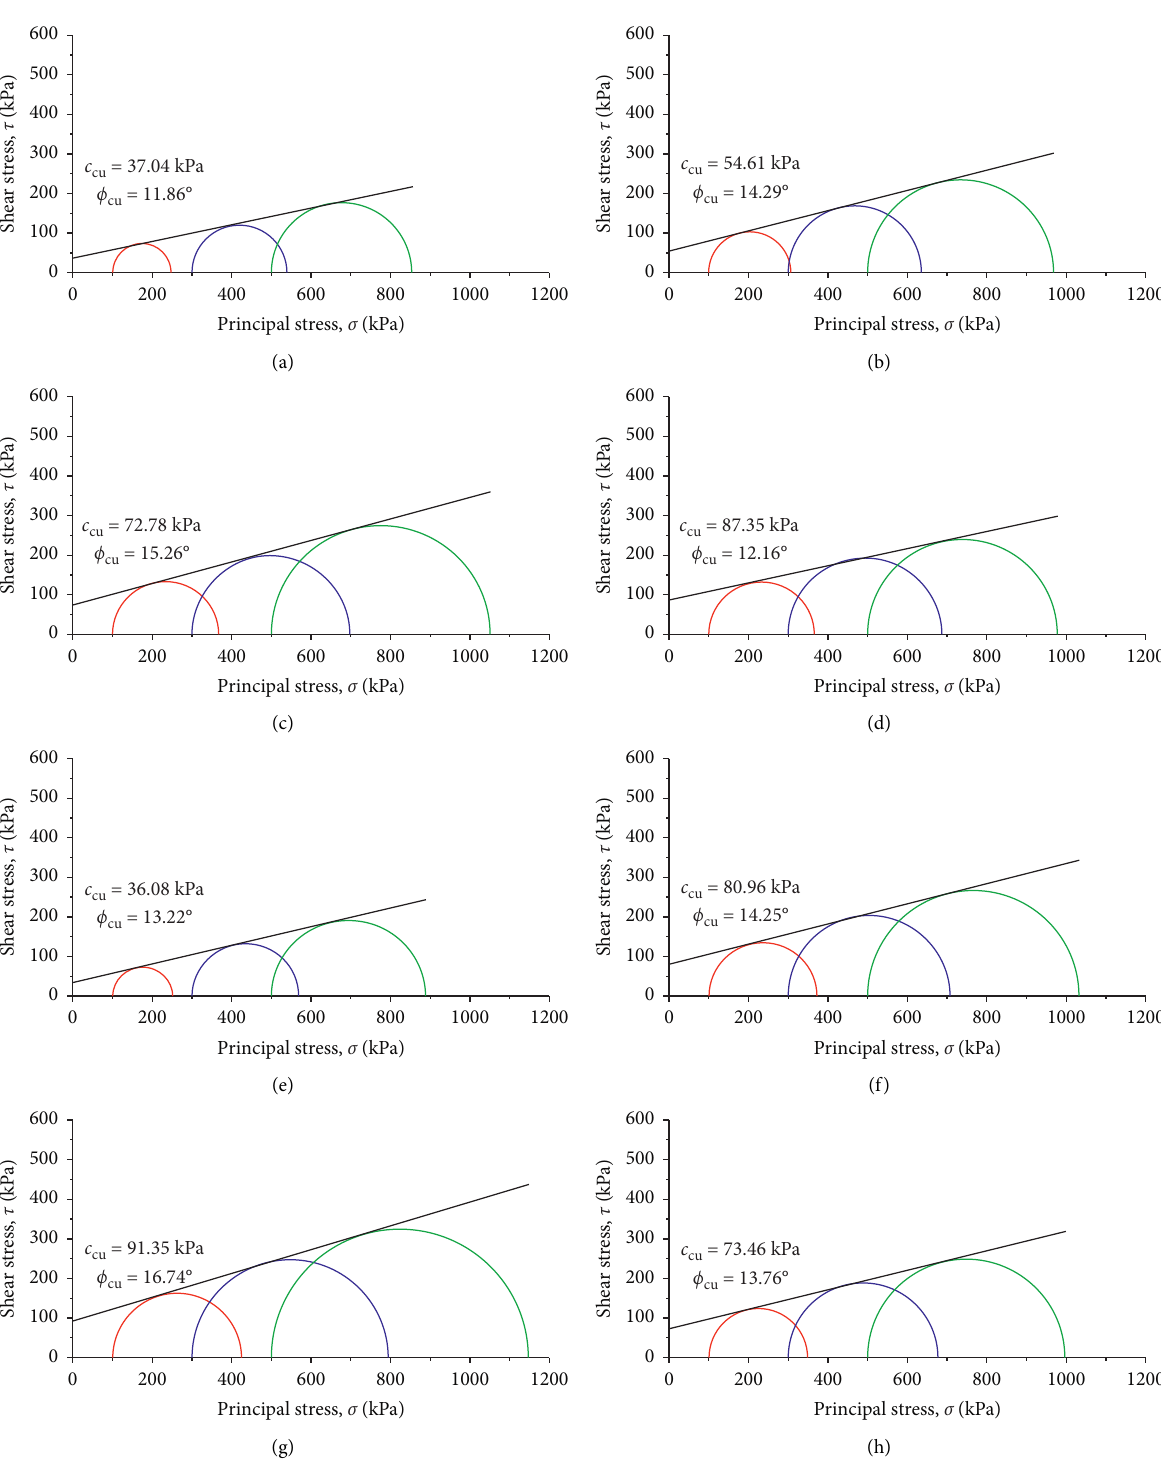
Figure 5: Mohr–Coulomb failure envelope of laterite and GN-laterite (red lines mean σ 3 � 100 kPa, blue lines mean σ 3 � 300kPa, green lines mean σ 3 � 500kPa, and black lines mean the damage envelope.), (a) ρ d � 1.30g/cm 3 , M � 0%, (b) ρ d � 1.40g/cm 3 , M � 0%, (c) ρ d � 1.50g/cm 3 , M � 0%, (d) ρ d � 1.40 g/cm 3 , M � 0.5%, (e) ρ d � 1.30 g/cm 3 , M � 1.0%, (f) ρ d � 1.40g/cm 3 , M � 1.0%, (g) ρ d � 1.50 g/cm 3 , M � 1.0%, and (h) ρ d � 1.40 g/cm 3 , M �